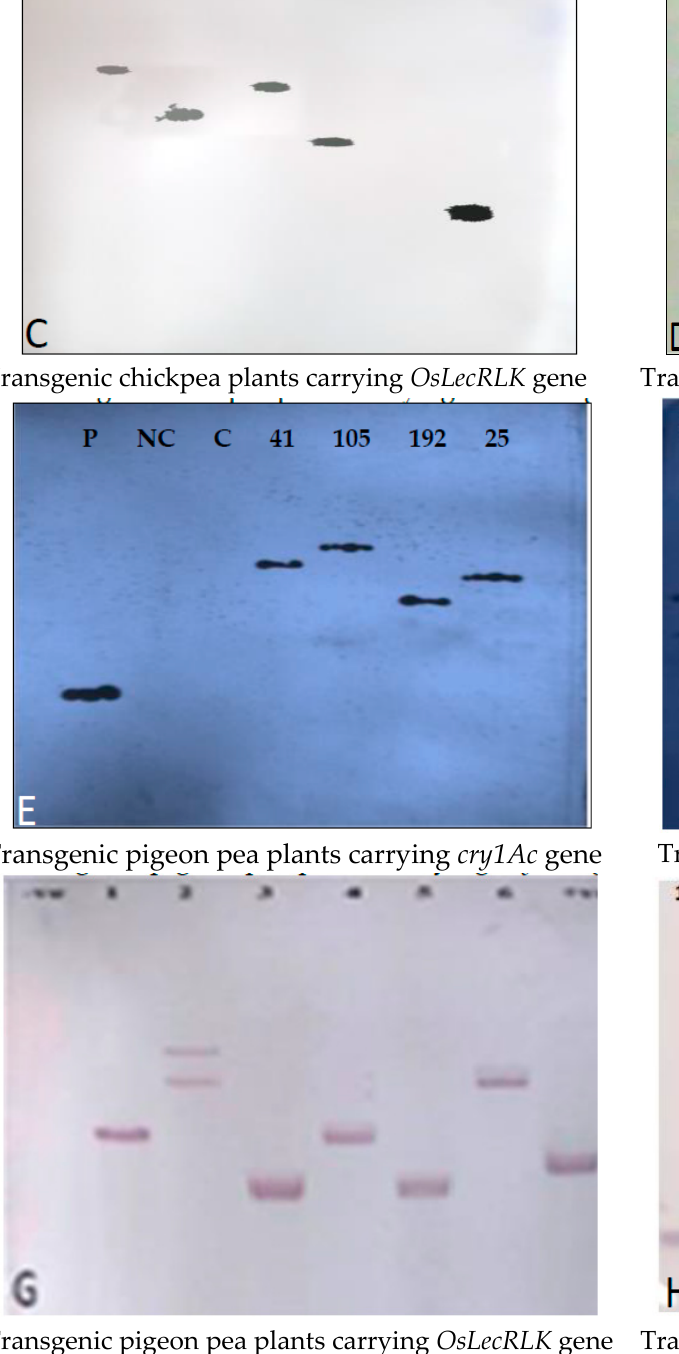
Figure 2. Southern blots depicting transgene integration and copy number in transgenic lines de- veloped using the protocol